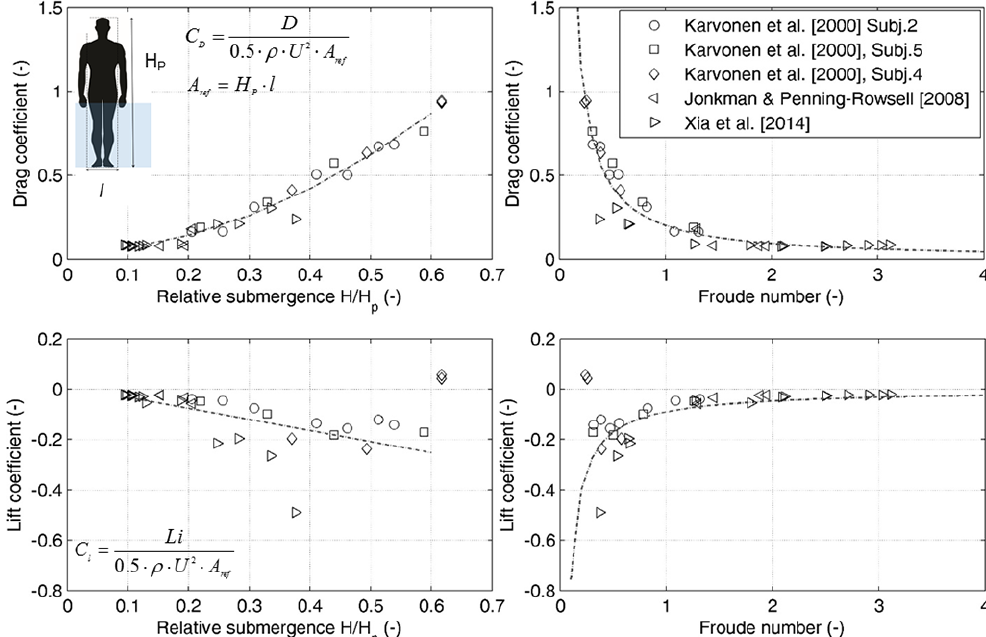
Figure 4. Estimated drag and lift coefficients versus Froude number (top left and bottom left panels respectively) and versus the relative submergence (top right and bottom right panels respectively) for the four human subjects (Karvonen et al., 2000; Jonkman and Penning- Rowsell, 2008) and the human-scale model (Xia et al., 2014). The inset in the first subplot shows the reference area used for the force coefficients